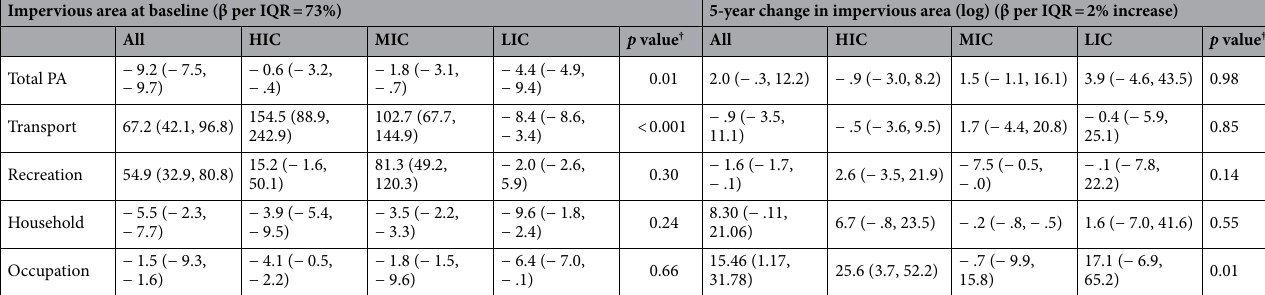
Table 4. Associations between impervious surface area at baseline, and 5-year impervious surface change prior to baseline, and individual-level physical activity. Adjusted Model: Age, sex, baseline year, education, wealth index, country income level, chronic disease at baseline, BMI, and nested random intercept for each community by center. Change model includes baseline impervious surface area. † p value for interaction between country income level and each urbanization metric. # β coefficients represent percent change in MET minutes per week of total or domain specific physical activity.